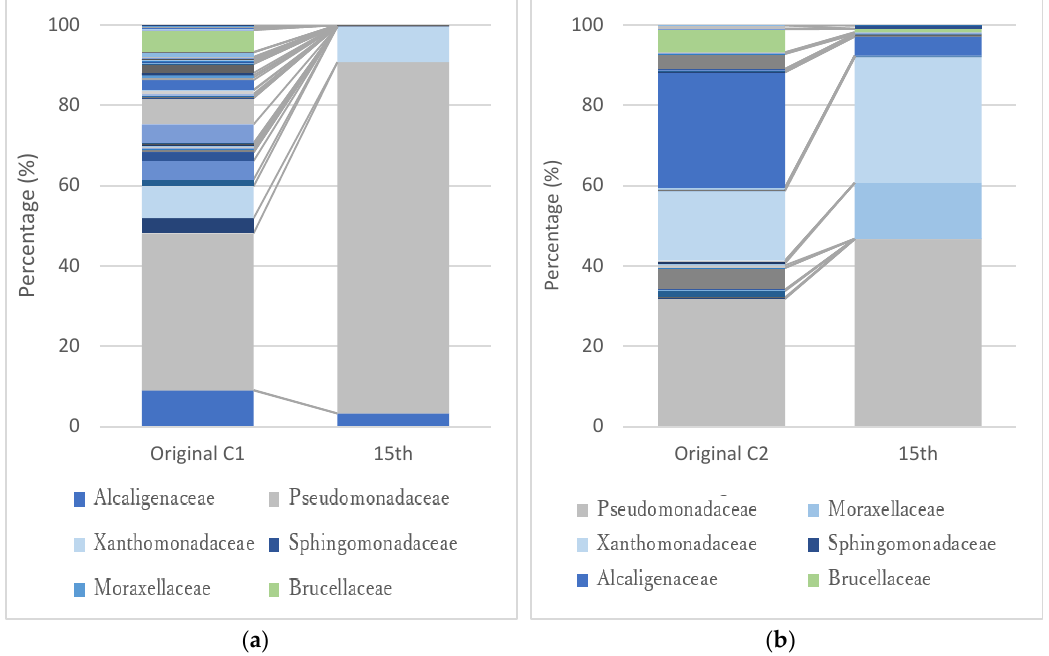
Figure 2. NGS profile of the consortia ( a ) Consortium C1 and ( b ) Consortium C2 enriched from a former gas station dominated by Pseudomonadeceae , Xanthomonadaceae , Alcaligenaceae , and Moxarelaceae after the 15th generation.